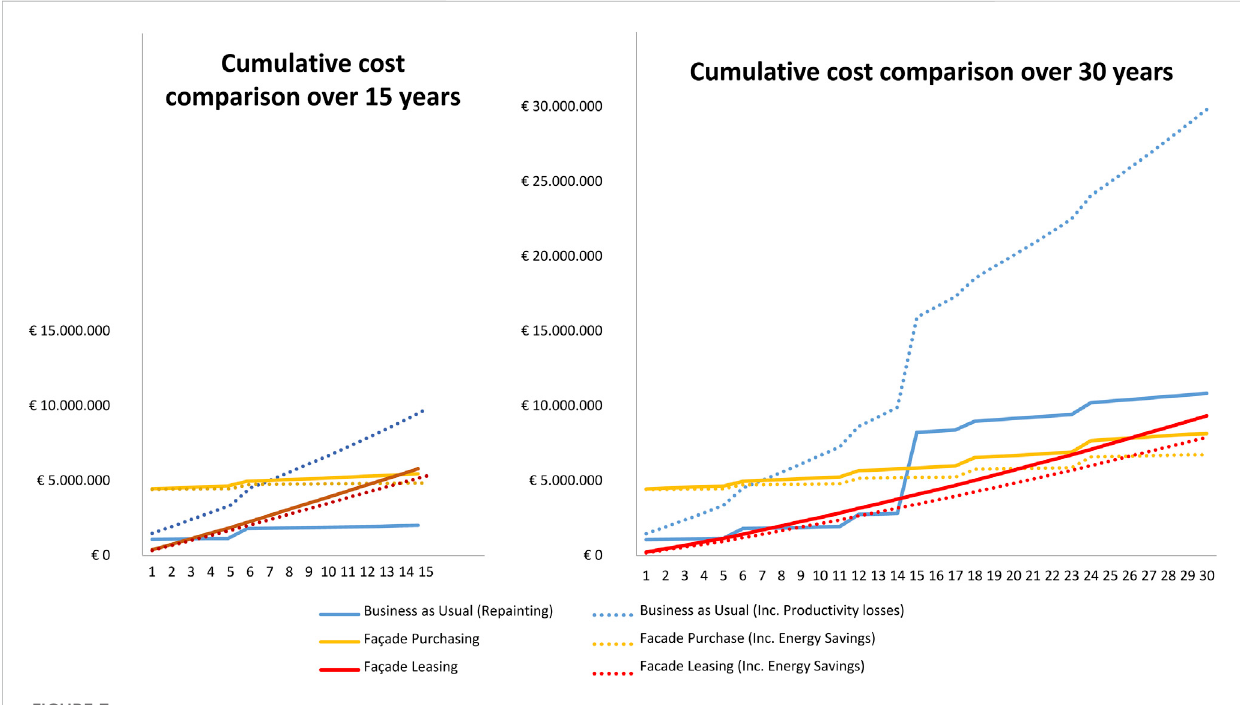
FIGURE 7 Distributed, cumulative Total Value of Ownership results comparing the three strategic scenarios for the CitG East façade renovation, including selected “ soft ” values. First published in: (Azcarate-Aguerre et al., 2020).